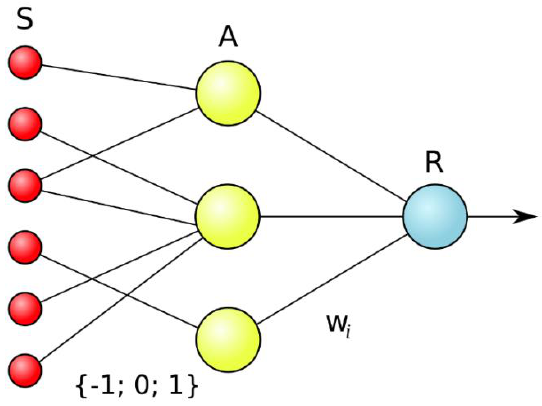
Figure 1. The structure of the perceptron neural network.